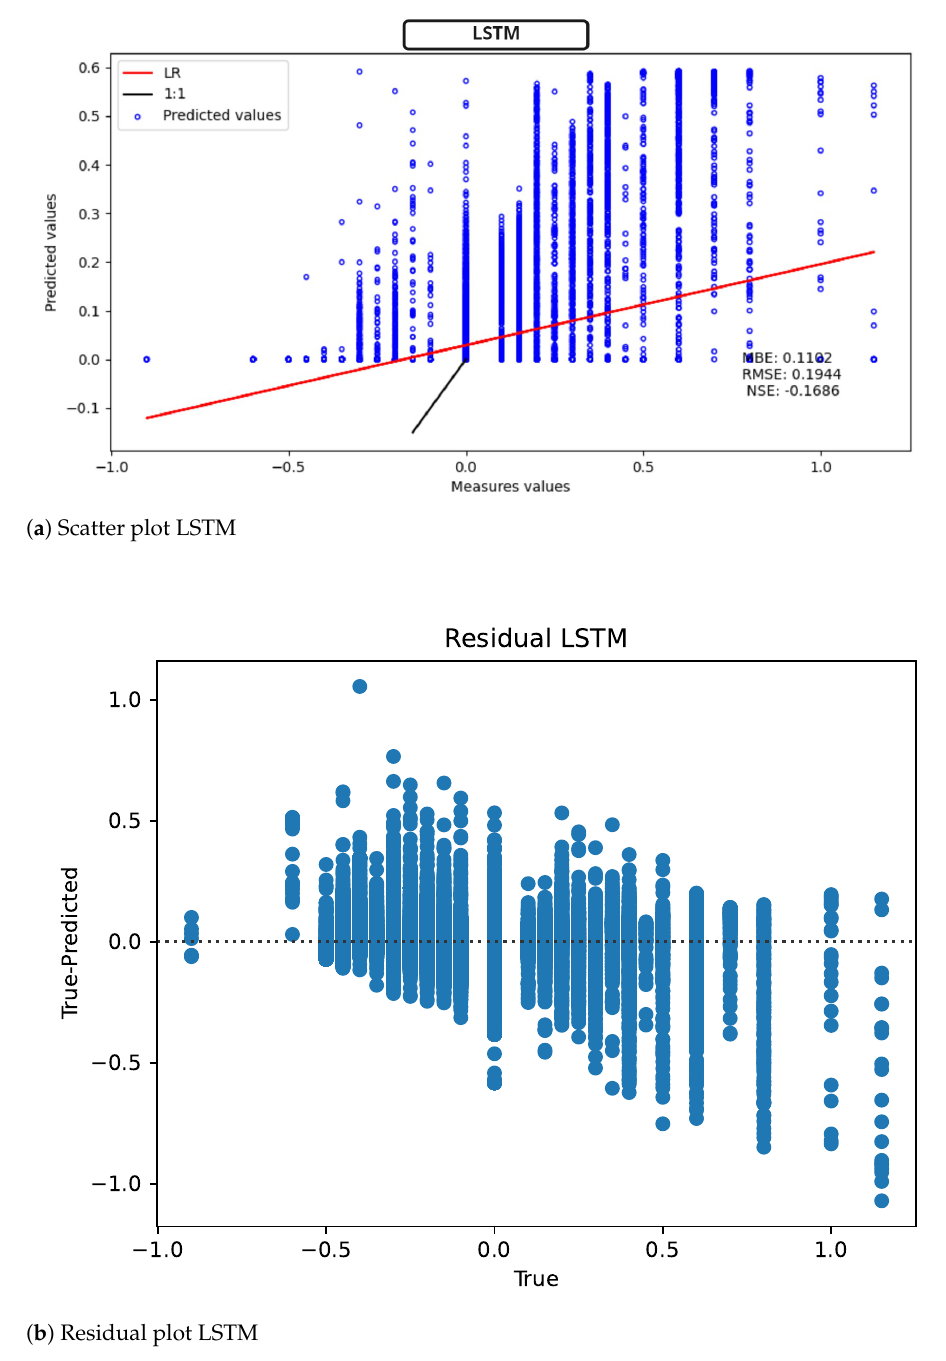
Figure 11. LSTM results for ST deviation calculation in ECG time